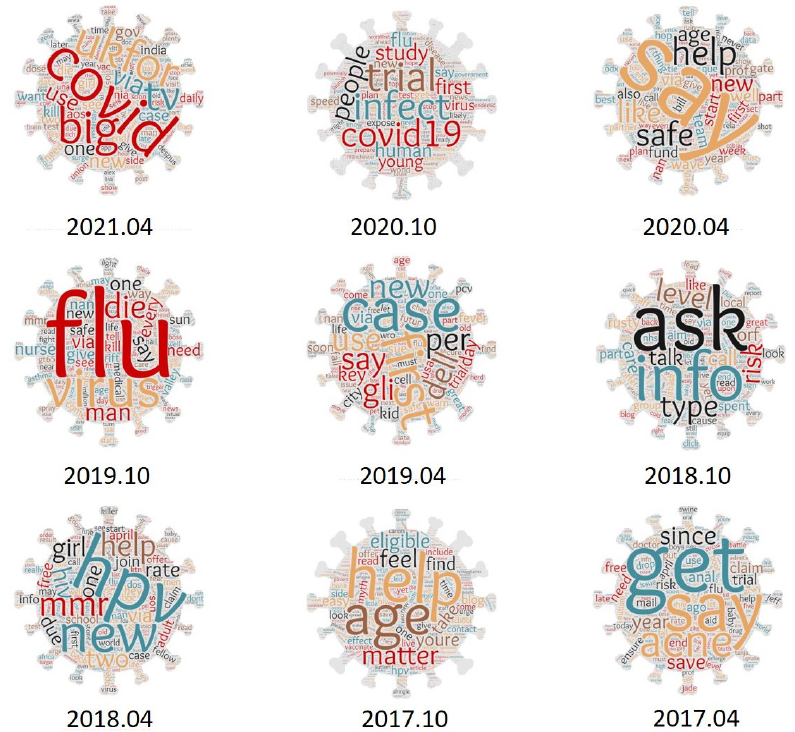
Figure 4. Word clouds for each time period, labelled by the closing date of that time